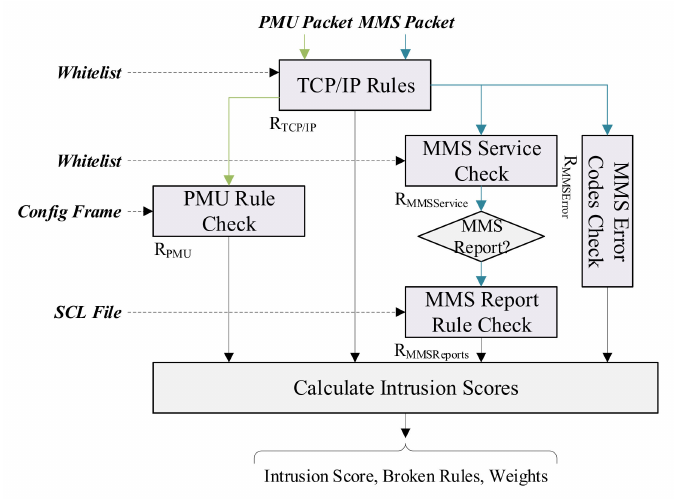
Figure 4. Basic architecture and workflow of the specification-based NIDS.